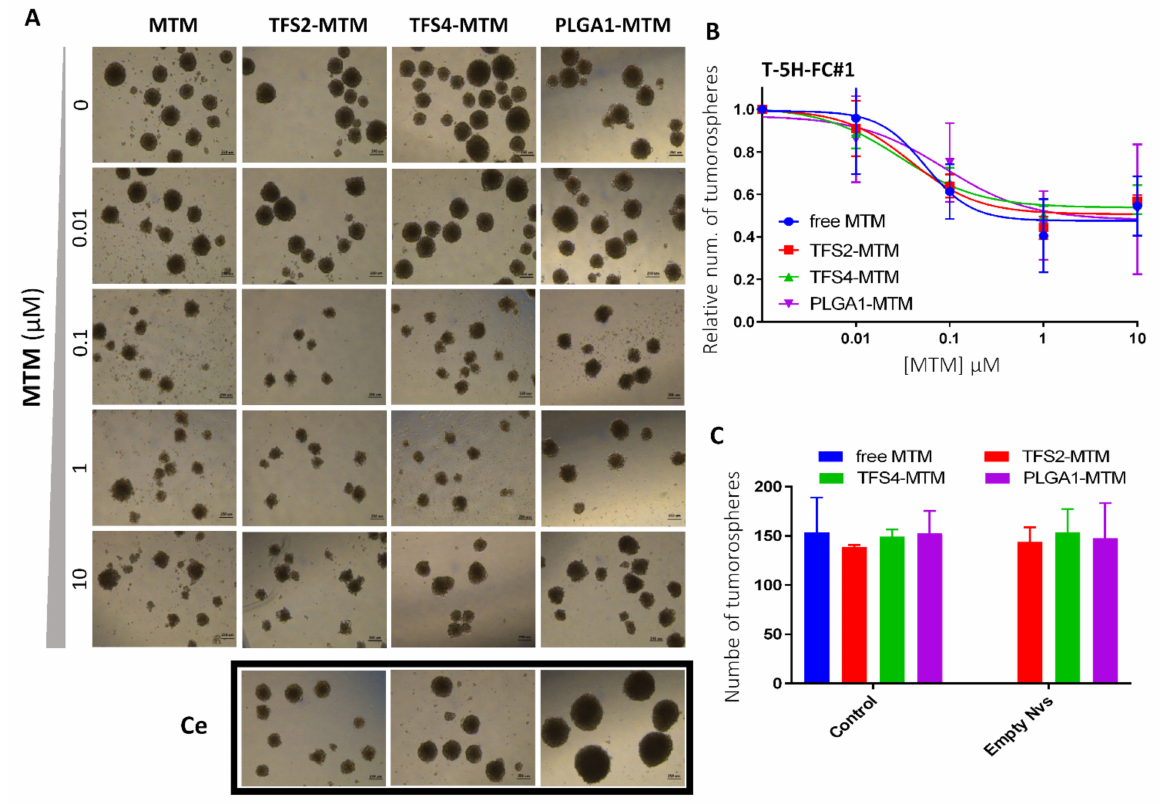
Figure 3. Effect of free and nano-encapsulated MTM in CSC-enriched 3D sarcoma cell cultures. ( A ) Cells were plated at low density in tumorsphere medium and left to form tumorspheres for 10 days before treating them for 72 h with increasing concentrations of MTM. Treatments with an amount of empty nanoparticles corresponding to 10 µ M (Ce) were also included. Scale bars = 250 µ m. ( B , C ) Quantification of the spheres (represented as % of control) remaining after the treatment with MTM-loaded nanoparticles; ( B ) or with empty nanoparticles ( C ). Error bars represent the standard deviation of three independent